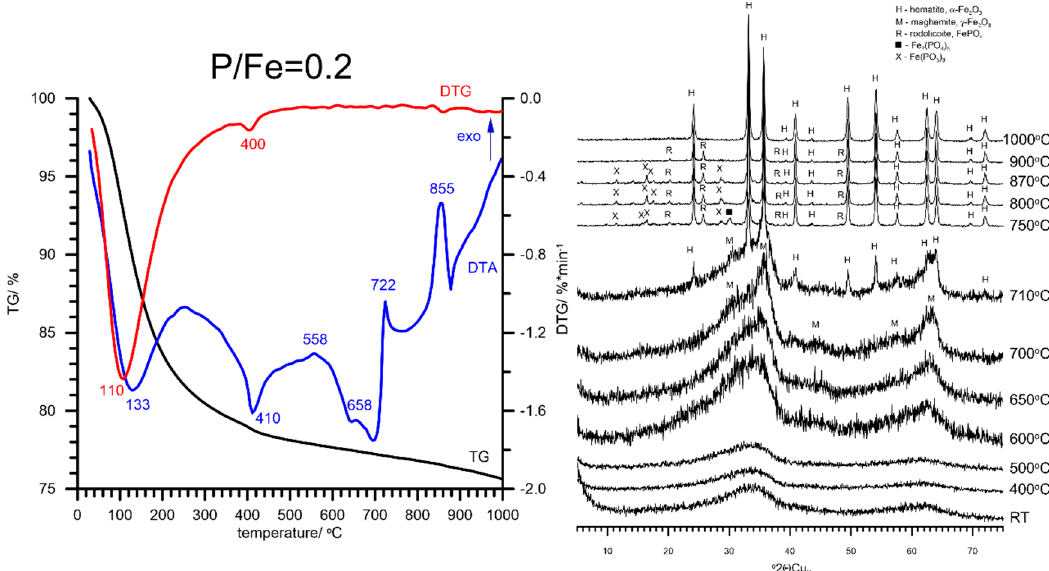
Figure 5. The results of thermal analysis and XRD patterns of P-doped synthetic ferrihydrite at low P/Fe molar ratio are equal to 0.2. Note the formation of nanomaghemite γ -Fe 2 O 3 at around 700 °C and rodolicoite FePO 4 associated with Fe(PO 3 ) 3 at 750 °C. These intermediate phases are unstable and convert into α -Fe 2 O 3 , which is the final product of ferrihydrite transformation.